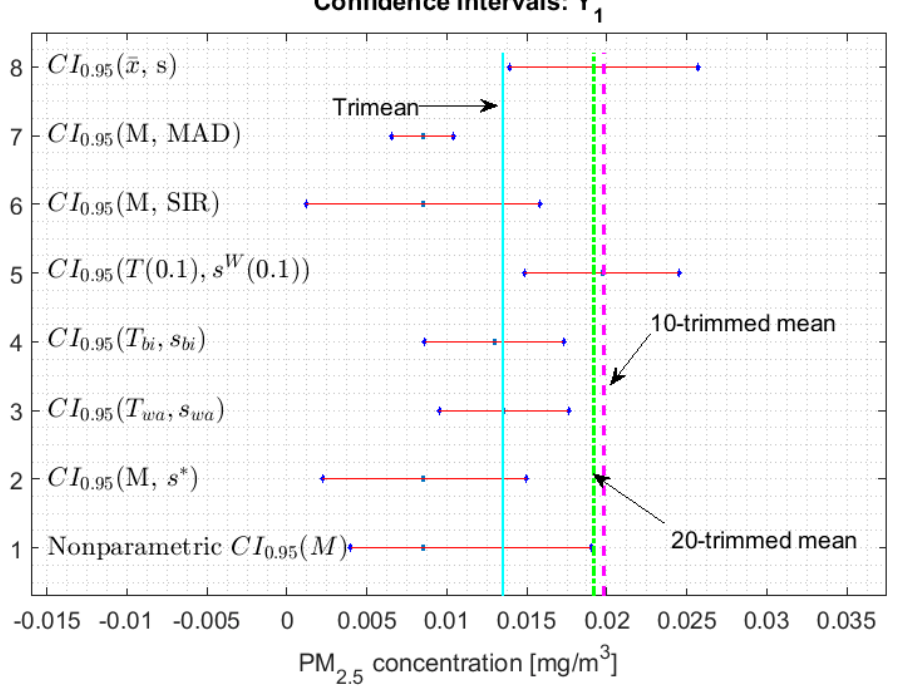
Figure 5. 95% confidence intervals ( CI 0.95 ) for robust and non-robust estimators: Y 1 .